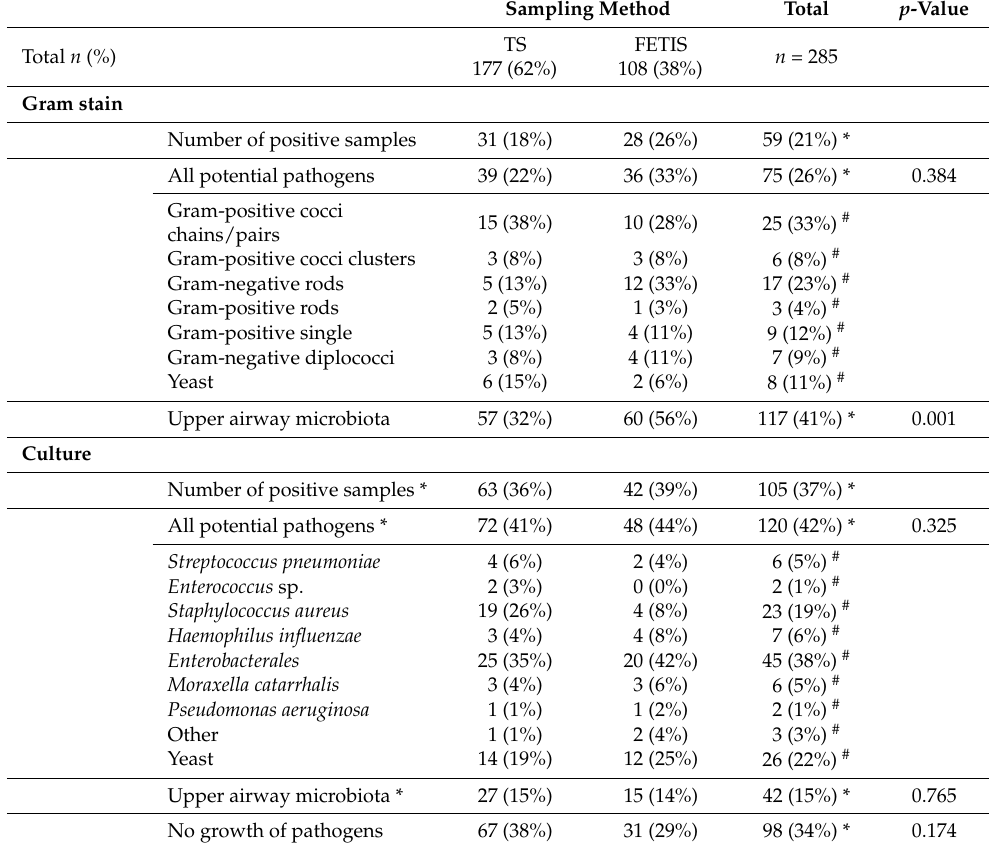
Table 1. Findings from Gram stain and culture from tracheal secretions (TS) and sputum samples collected by FET and IS